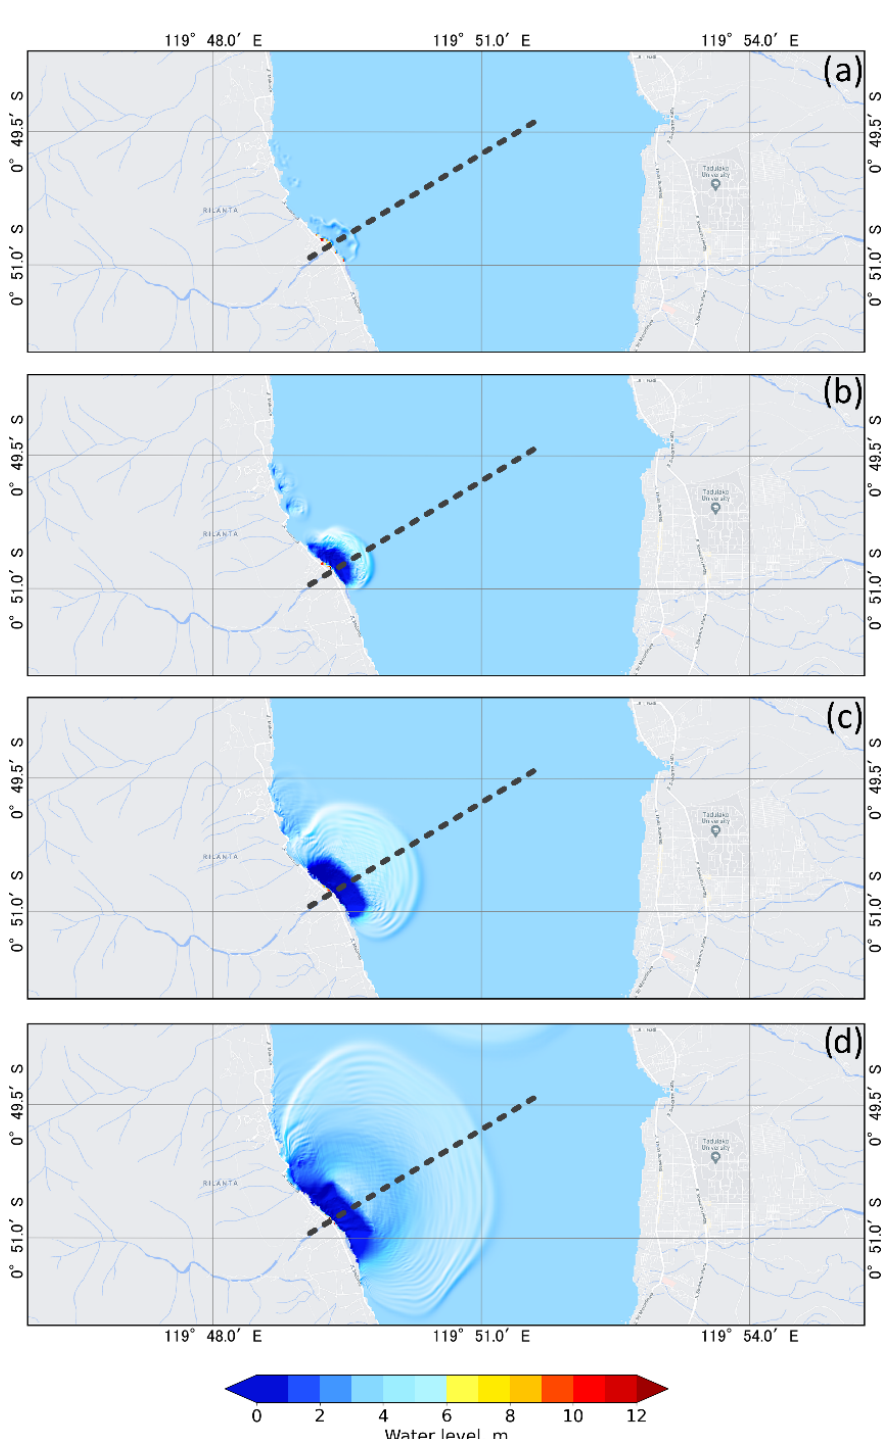
Figure C2. Temporal evolution of the 2018 Sulawesi–Palu tsunami wave (a) 2, (b) 10, (c) 30, and (d) 60s after the S8 landslide (Pakoksung et al.,